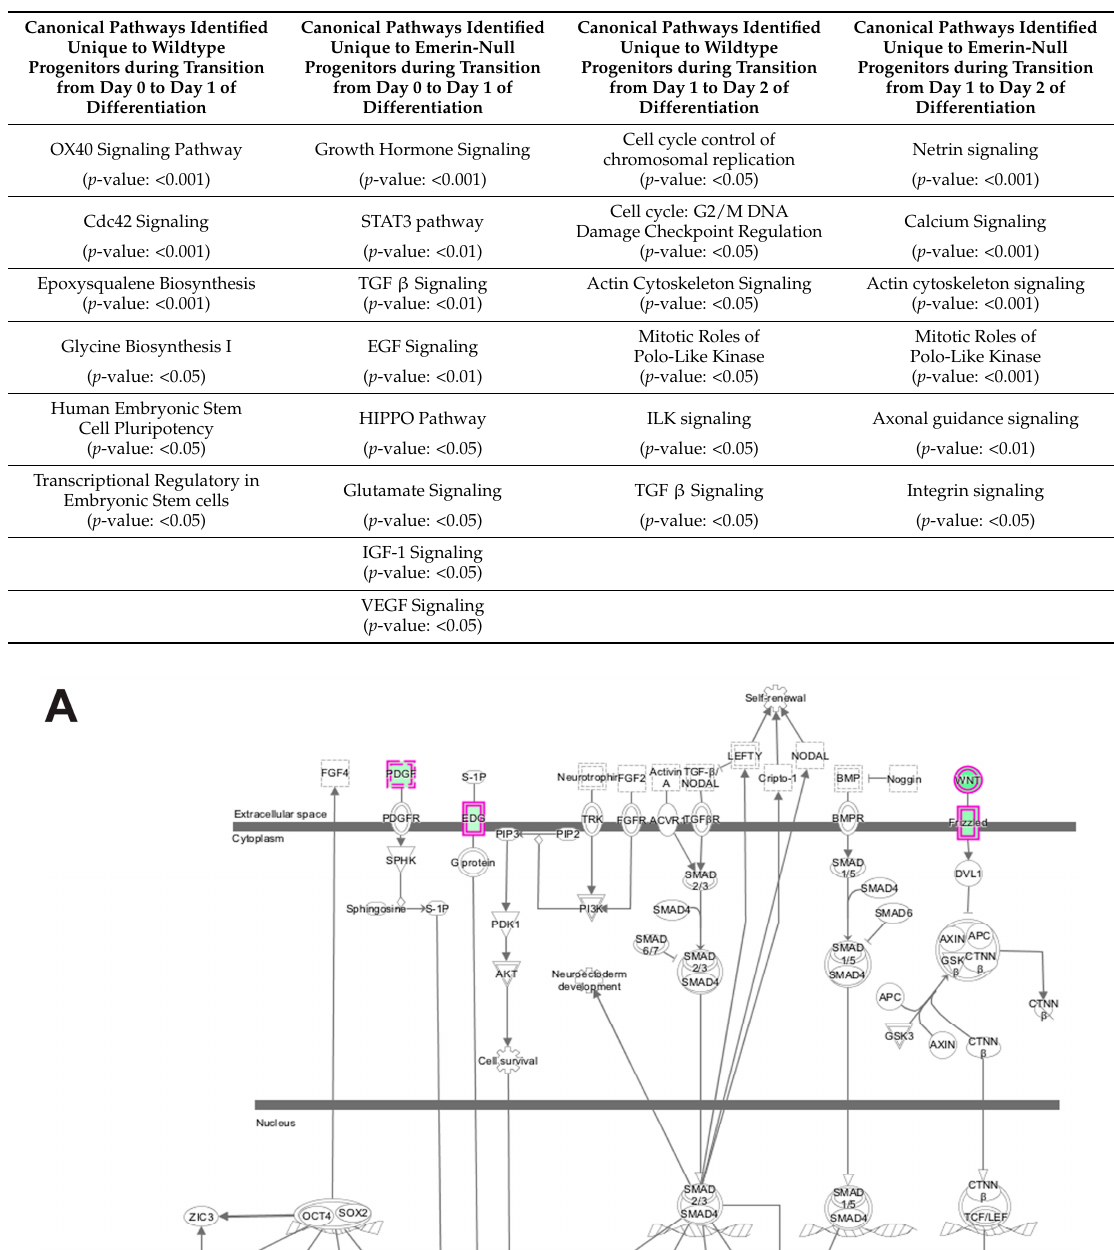
Table 2. List of Enriched Canonical Pathways from genes unique to either wildtype cells or emerin-null cells during key differentiation transitions using Ingenuity Pathway Analysis.